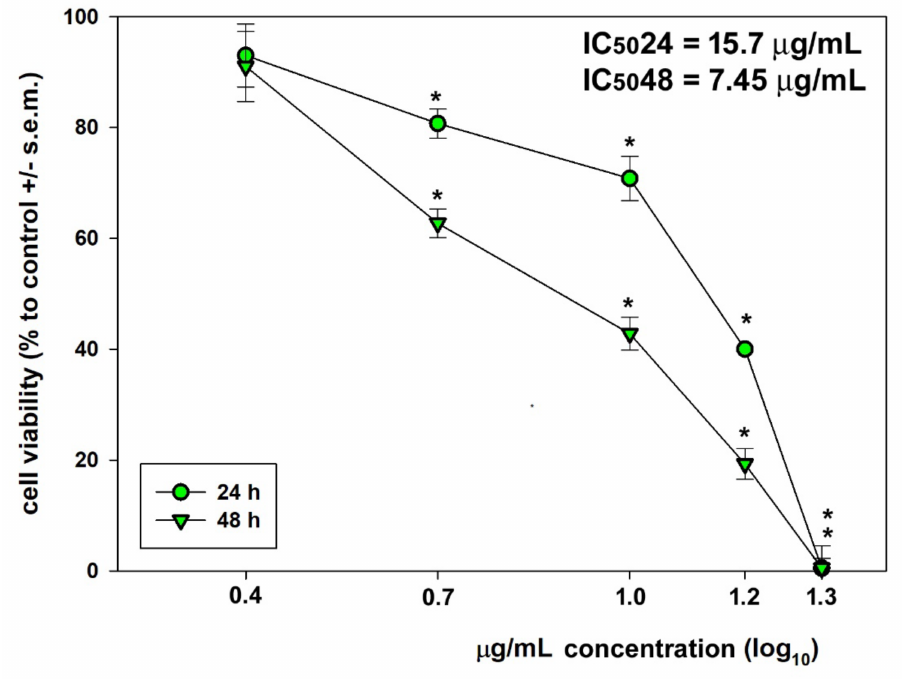
Figure 2. Dose-response effect of the CFE from A. lixula at 2.5, 5, 10 and 15 µ g/mL concentration on the viability of HepG2 after either 24 or 48 h of exposure. The error bars correspond to the standard error of the mean (s.e.m.) of three independent measurements. * p <